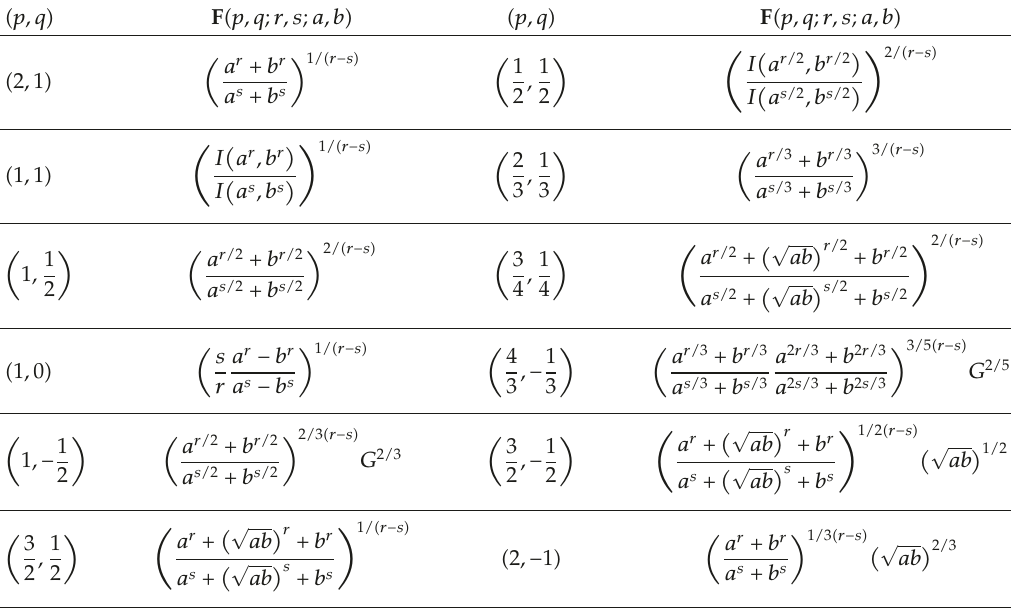
Table 1: Some familiar two-parameter mean